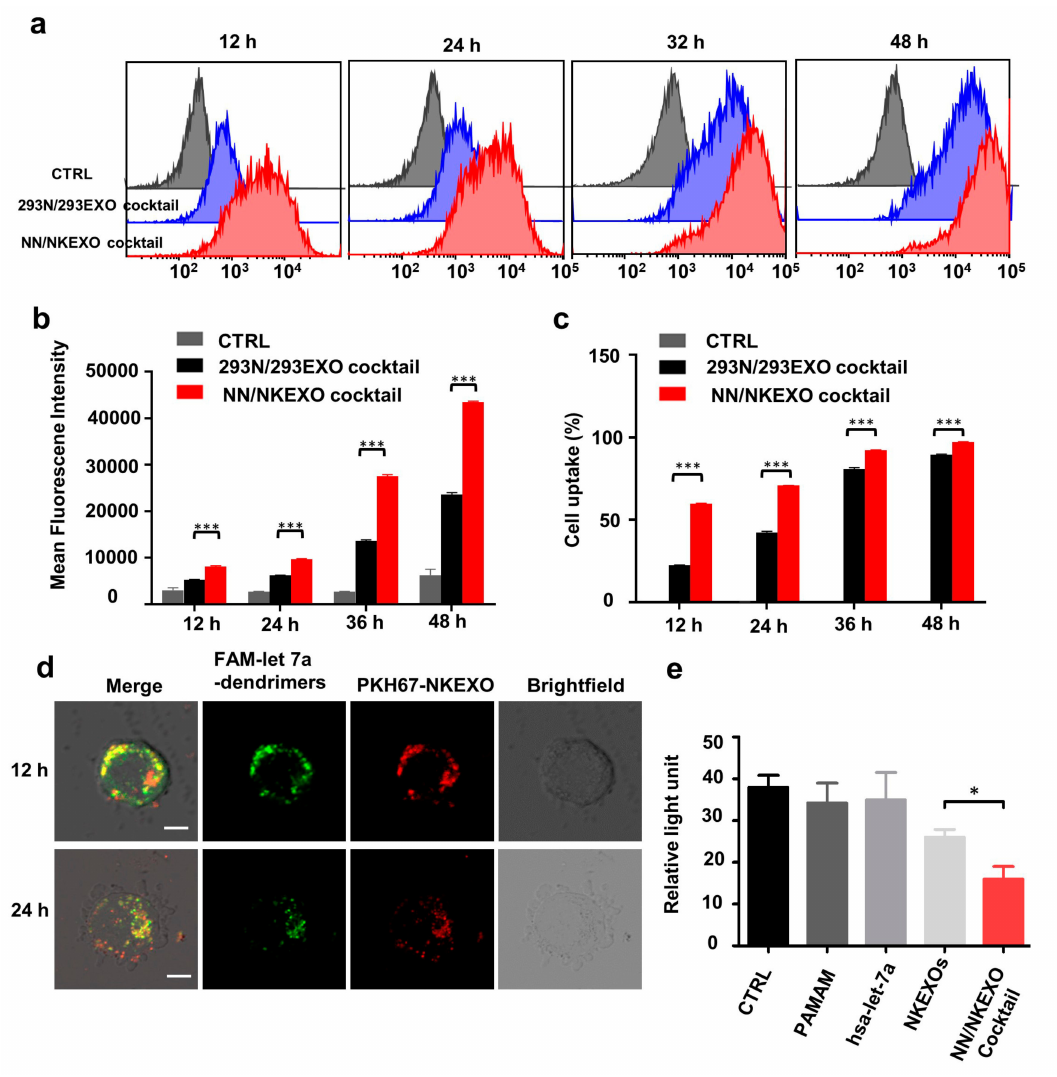
Figure 3. Binding and cytotoxicity of the NN / NKEXO cocktail to a human neuroblastoma cell line in vitro. ( a ) Representative confocal fluorescence images of CHLA-255 cells after treatment with NN / NKEXO cocktail for 12 and 24 h (let-7a-dendrimer: Green; NKEXO: Red). ( b ) Quantitative flow cytometric analysis of CHLA-255 cells incubated with control medium, 293N-293Exo cocktail and NN / NKEXO cocktail both made of let-7a (0.5 µ g) and their exosomes (50 µ g) for 12, 24, 36 and 48 h; n = 3. ( c ) Mean fluorescence intensity of CHLA-255 cells after 12, 24, 36 or 48 h incubation with control medium and di ff erent cocktails; n = 3. ( d ) Percentages of cells with increased miRNA fluorescence; n = 3. ( e ) Cell viability of CHLA-255 cells (10 4 cells per well) after treatment with PBS (CTRL), PAMAM, let-7a, NKEXOs and NN / NKEXO cocktail (40 µ g NKEXOs and 0.05 µ g let-7a) for 24 h. Data are presented as mean ± SD; n =